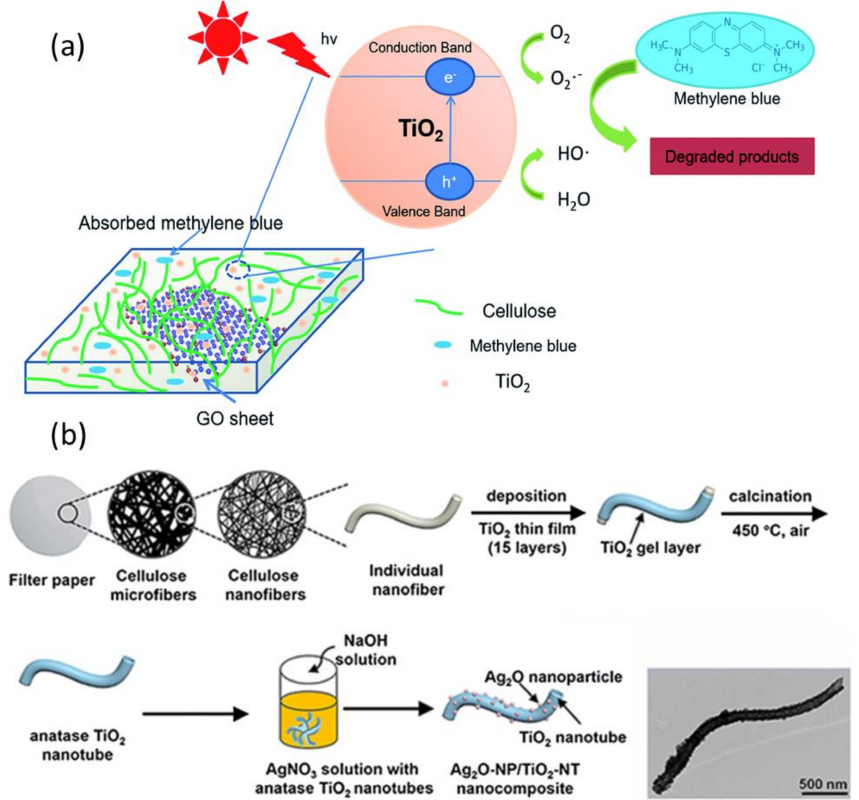
Figure 9. ( a ) Mechanism for photocatalytic treatment and degradation of an organic pollutant (methylene blue) in wastewater using graphene oxide (GO)/cellulose/TiO 2 nanocomposites [190], ©Royal Society of Chemistry, 2020. ( b ) Deposition of TiO 2 nanotubes and AgO x nanoparticles (NPs) onto cellulose nanofibers (CNFs) for improved photocatalytic cleaning of wastewater [191], ©Springer,